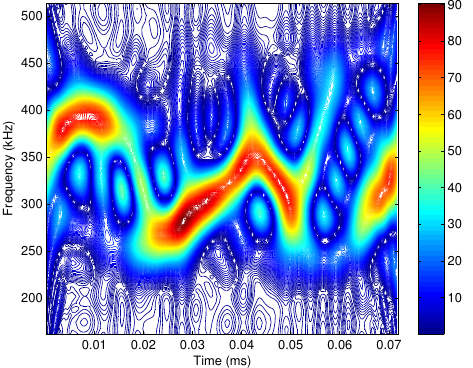
Figure 6. The time frequency distribution of the SC-FDMA